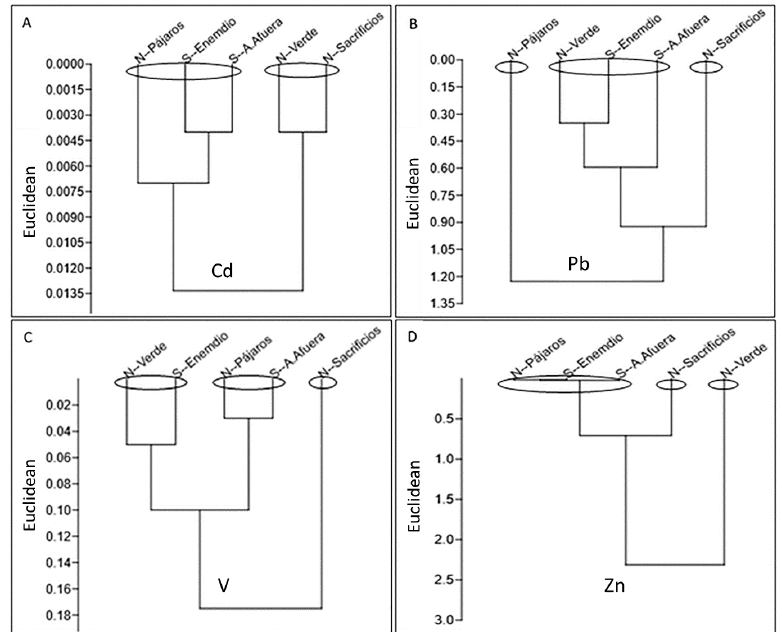
Figure 2. Similarity of heavy metal concentrations in P. volitans muscle tissue, in North (N) and South (S) reefs of the Veracruz Reef System National Park. Cluster of similarity ( A , cadmium), ( B , lead), ( C , vanadium), ( D , zinc).